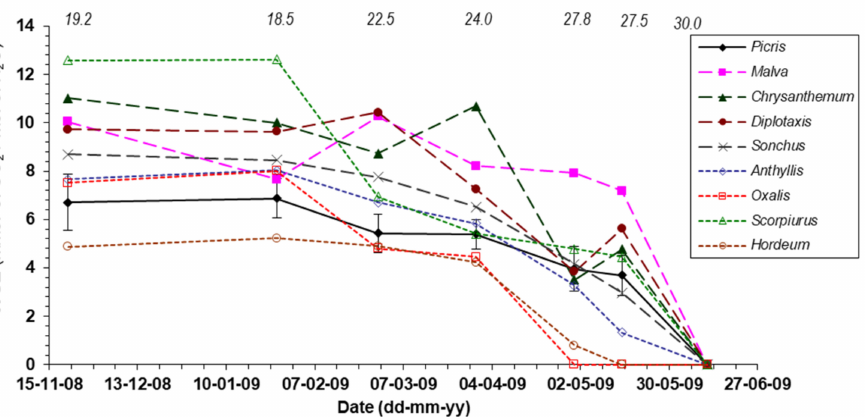
Figure 3. Seasonal pattern of instantaneous water-use efficiency (WUE) for nine plant species on sunny days. The numbers above indicate the ambient temperature at the measurement time ( ◦ C). The differences among species were significant in all the measurement dates ( p < 0.001), except in June due to plant senescence. Species: Picris willkommii (Schultz Bip.) Nyman, Malva sylvestris L., Chrysanthemum coronarium L., Diplotaxis virgata (Cav.) DC., Sonchus asper (L.) Hill, Anthyllis cytisoides L., Oxalis pes-caprae L., Scorpiurus sulcatus L. y Hordeum murinum L. In order to clarify the figure, only